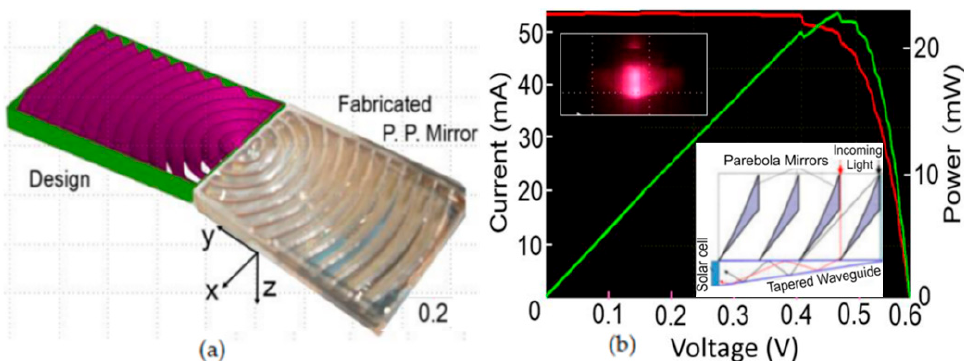
Figure 7. ( a ) Periodic parabola mirrors (PPMs): (left) design, and (right) fabricated PPM; ( b ) 2DPRCS demonstration using planar tapered waveguide (WG) and concentric periodic parabola mirrors (bottom inset), i.e., the I–V characteristics of a Si solar cell set at the edge of the planar tapered WG, and the concentrated light field at the edge of the planar tapered WG (top inset).